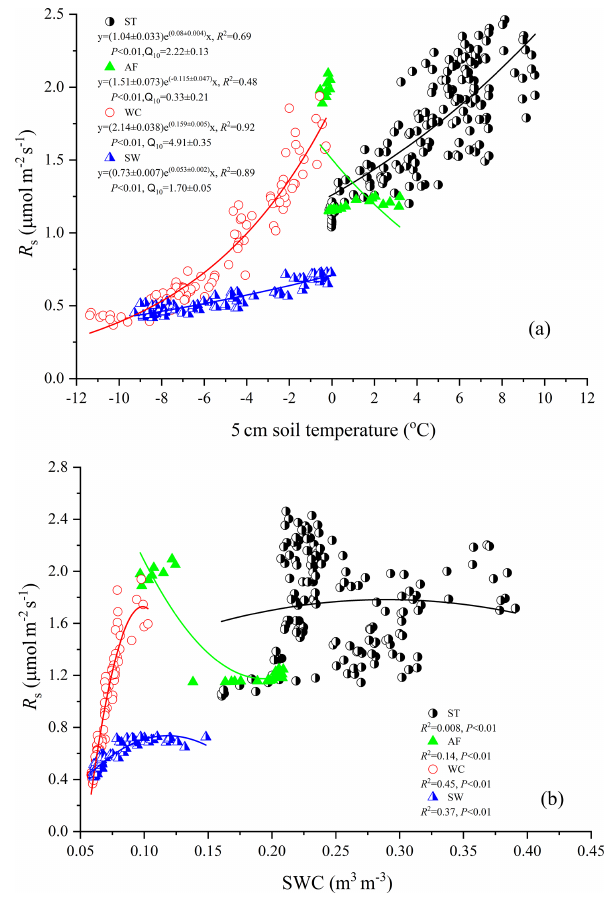
Figure 4. Relationship between soil temperature (a) and mois- ture (b) at a 5cm depth and measured R s flux for the summer thaw- ing stage (ST), autumn freezing stage (AF), winter cooling stage (WC), and spring warming stage (SW). Table 3. The start–stop time and duration of different freeze–thaw stages of the active layer.